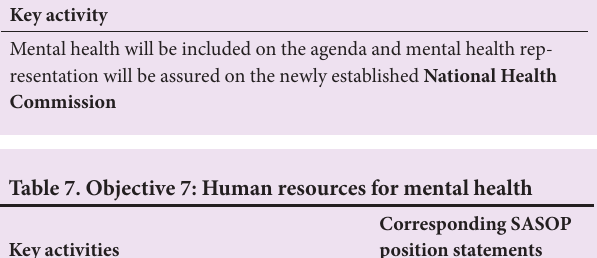
Table 6. Objective 6: Intersectoral collaboration